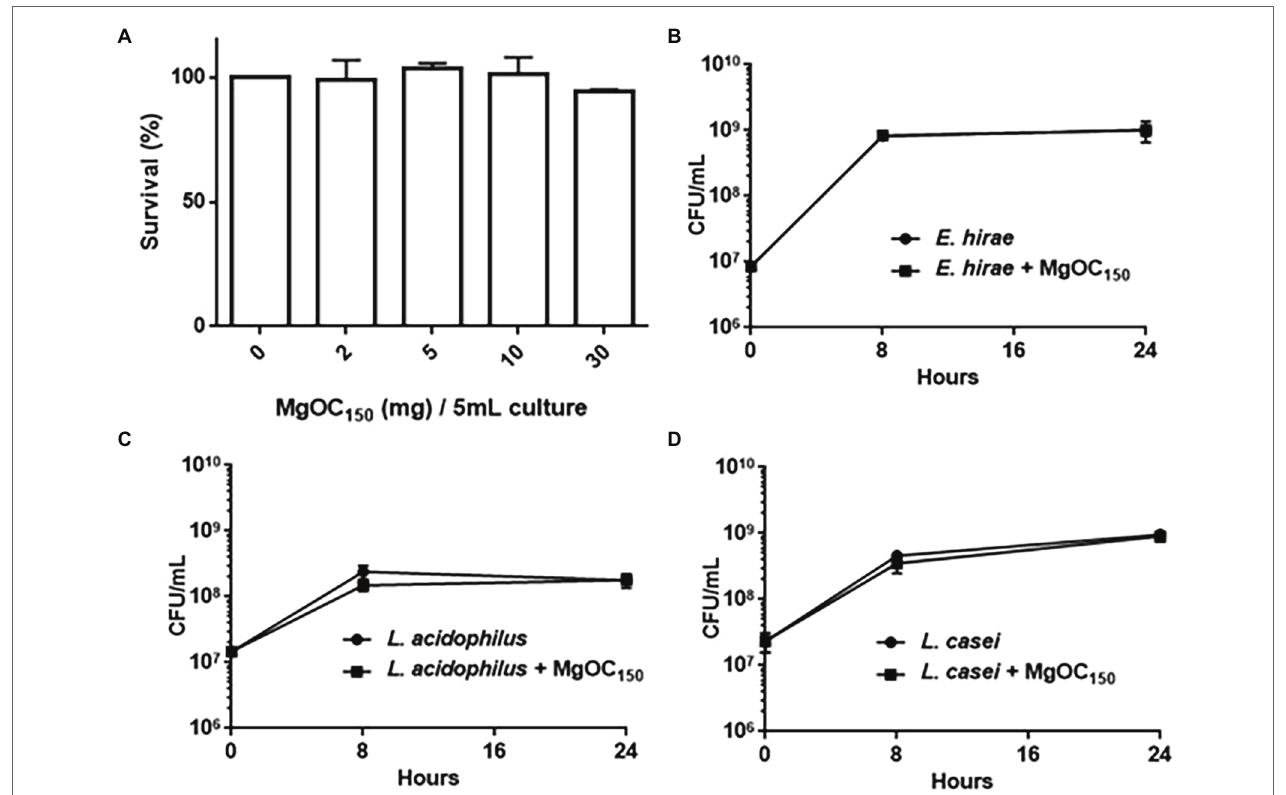
FIGURE 6 | Toxicity of MgOC 150 in host cells and normal intestinal flora. (A) Survival of Caco-2 cells after incubation with without MgOC 150 . MgOC 150 was added into 150 μ l Caco-2 cell cultures. Amounts (mg) of MgOC 150 on x -axis were represented as those corresponding to 5 ml cultures. The survival rates are presented as the percentage of the RLU value for the cells after incubation with MgOC 150 relative to that after incubation without MgOC 150 . Growth of several normal intestinal flora, E. hirae (B) , L. acidophilus (C) , and L. casei (D) cultured with and without MgOC 150. All strains were anaerobically cultured with and without 30 mg MgOC 150 . Bacterial growth was estimated by measuring the